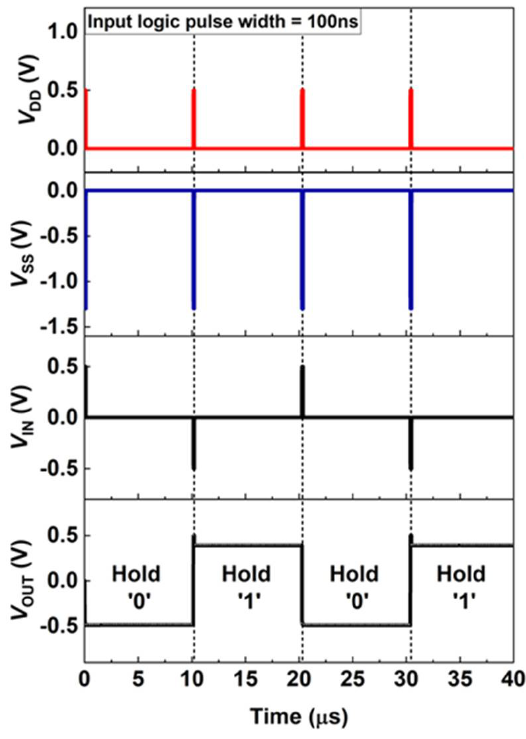
Figure 6. Holding characteristic with zero supply voltage. Timing diagrams of applied voltage ( V DD , V SS and V IN ) with a logic pulse width of 100 ns and the corresponding output voltage ( V OUT ). The holding operation lasted for 10 μs.